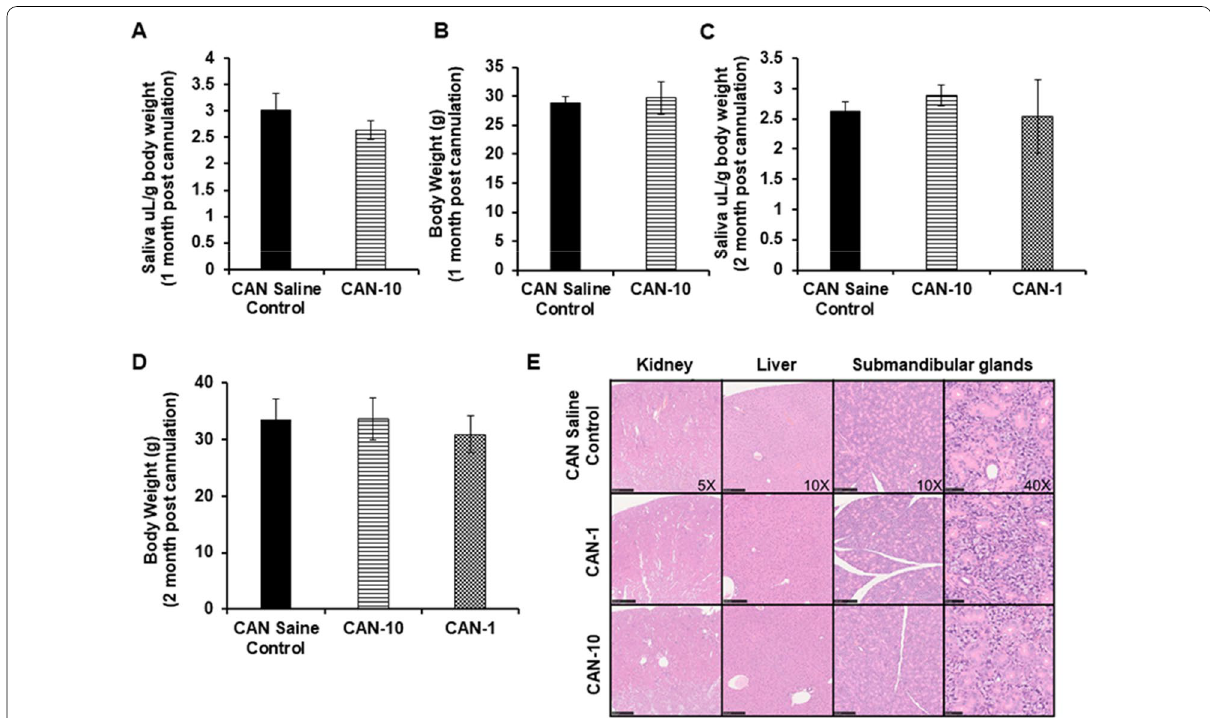
Fig. 5 Effect of instillation of 10 nmoles (CAN-10) and 1 nmoles (CAN-1) of DCFPyL in submandibular glands via cannulation at different times (1 or 2 months) on saliva secretion ( a , c ) and body weight ( b , d ). a and c Each bar represents mean saliva volume (µL) normalized to body weight (g) SD. b and d Each bar represents mean body weight (g) ± kidney, liver, and submandibular gland of various